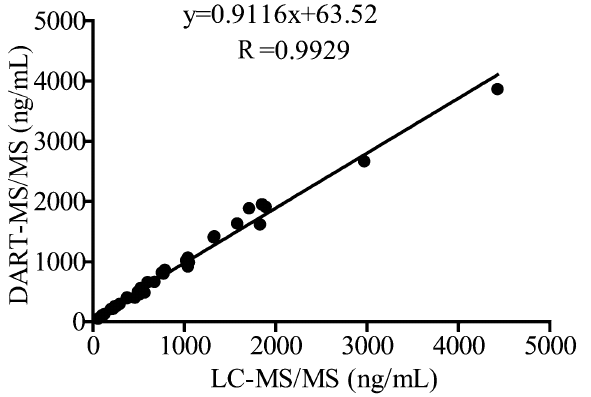
Figure 4. Correlation plot between concentrations measured by LC–MS/MS and DART–MS/MS for five anti- arrhythmic drugs and one metabolite in human serum, n =